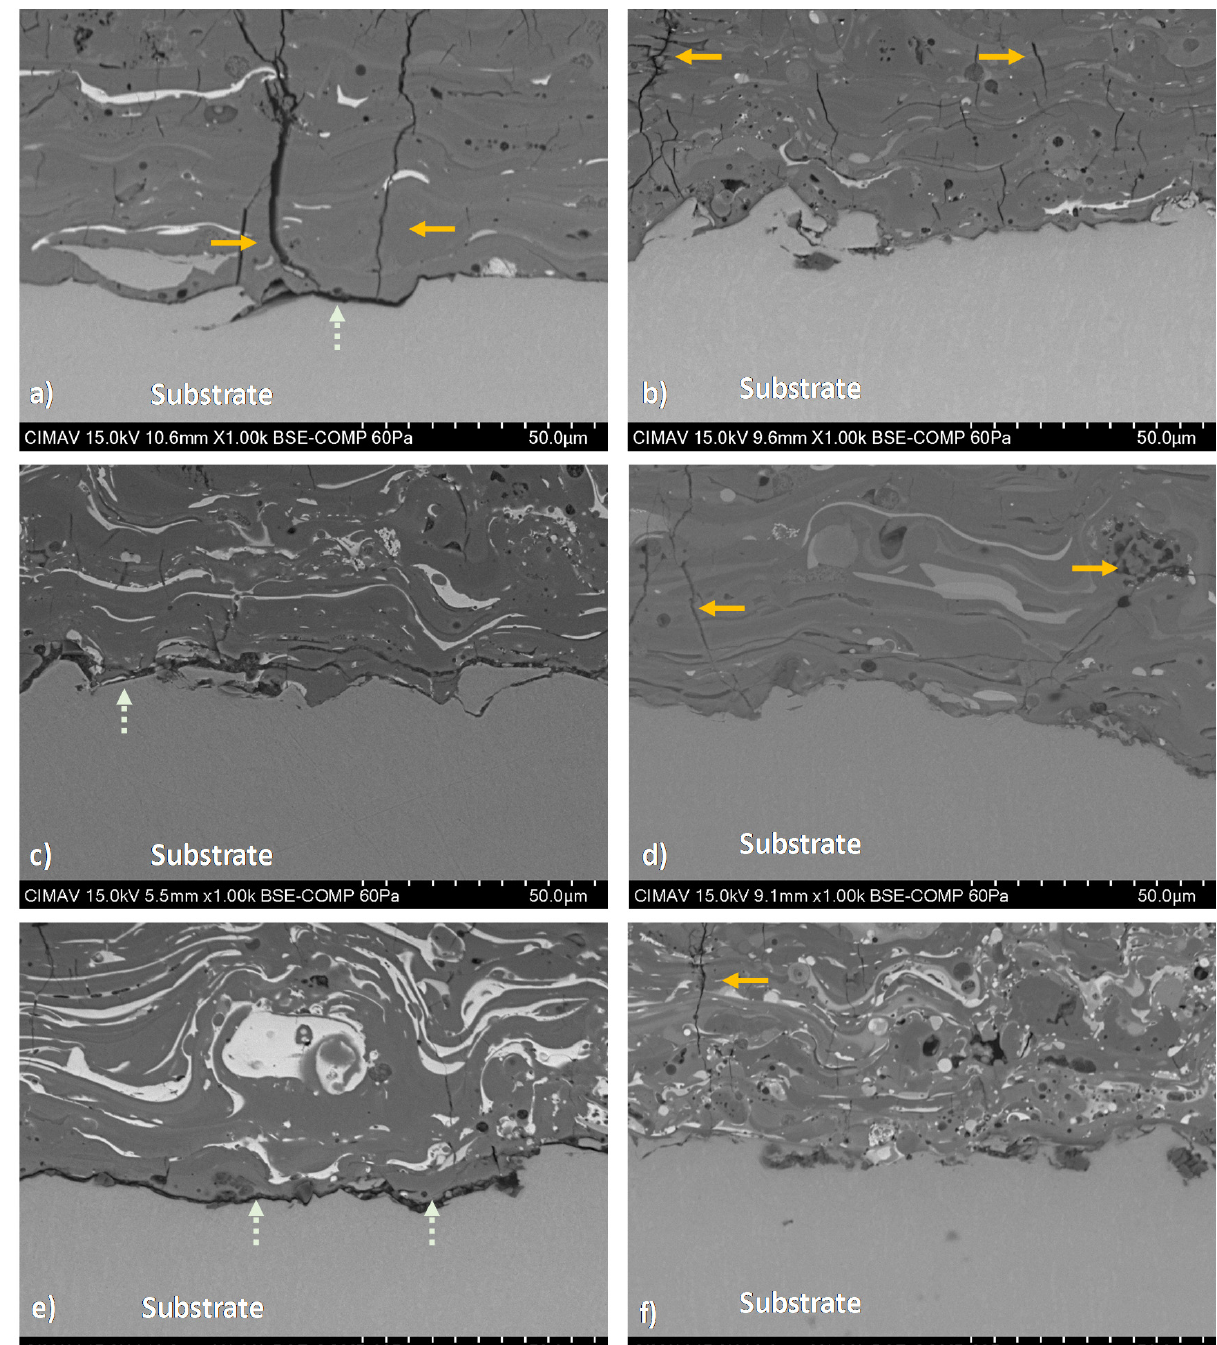
Figure 7. Cross-section BSE micrographs of coatings developed with (i) MSH powders; ( a ) HA10BT S, ( c ) HA30BT S, and ( e ) HA50BT S; and (ii) HEBM powders: ( b ) HA10BT BM, ( d ) HA30BT BM, and ( f ) HA50BT BM. The typically fractures of the coating marked by orange arrows, this due to high temperature reached during the APS deposition and rapid cooling. The light green arrows show the interface cracks due to poorly mechanical interlocking behavior.